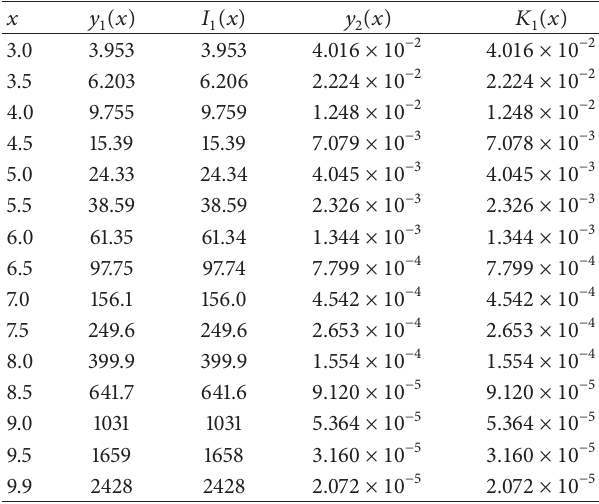
Table 6: Comparisons between the solution of Example 3 obtained with known modified Bessel functions and that calculated in this